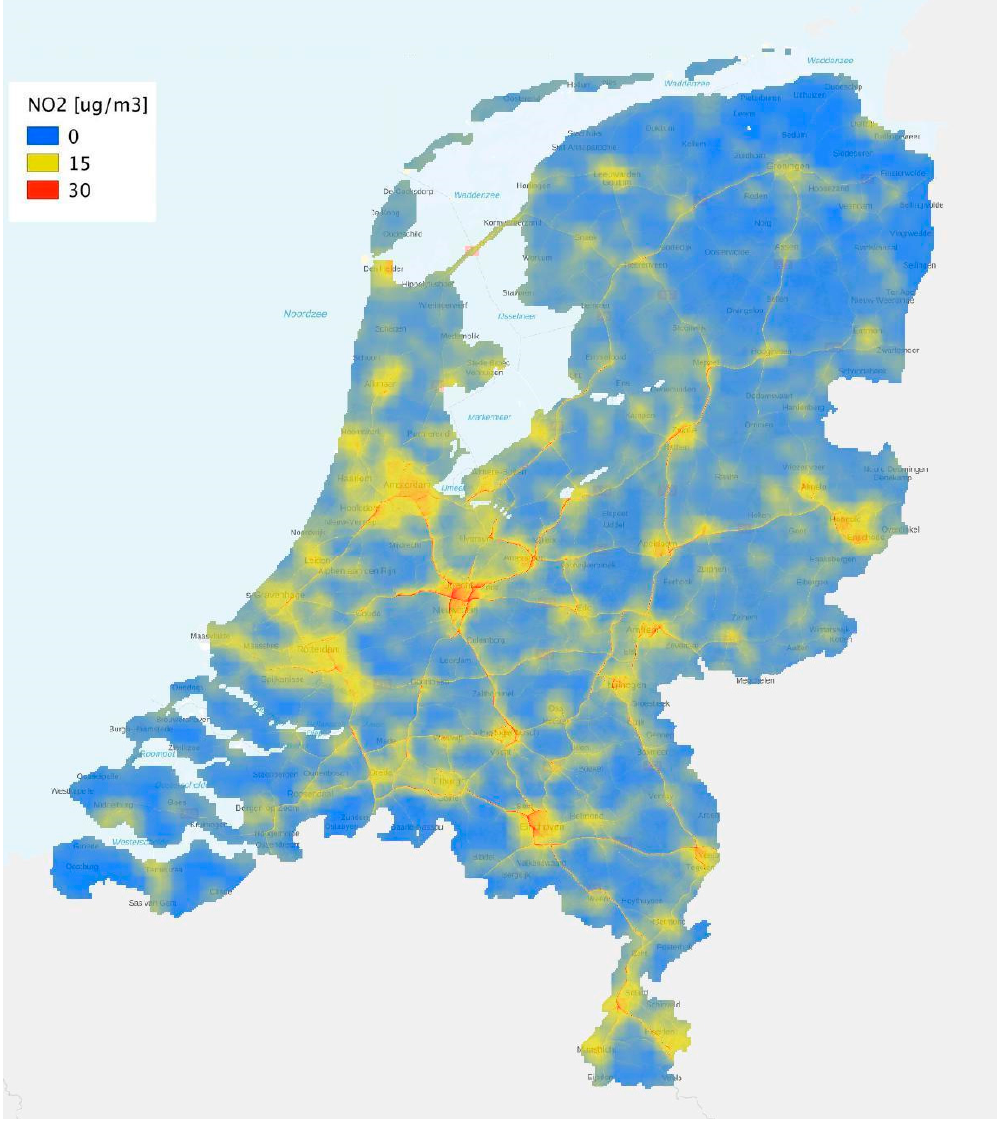
Figure 6. NO 2 map presented for the public at 16 June 2019, between 20:00 and 21:00 MET-DST. Blue areas correspond to NO 2 concentrations of 0 µg/m 3 and red areas correspond to 30 µg/m 3 . The map was published on https://samenmeten.rivm.nl/uurkaart/ and on www.luchtmeetnet.nl, shortly after 16 June 2019, 21:00 MET-DST although using different color schemes.